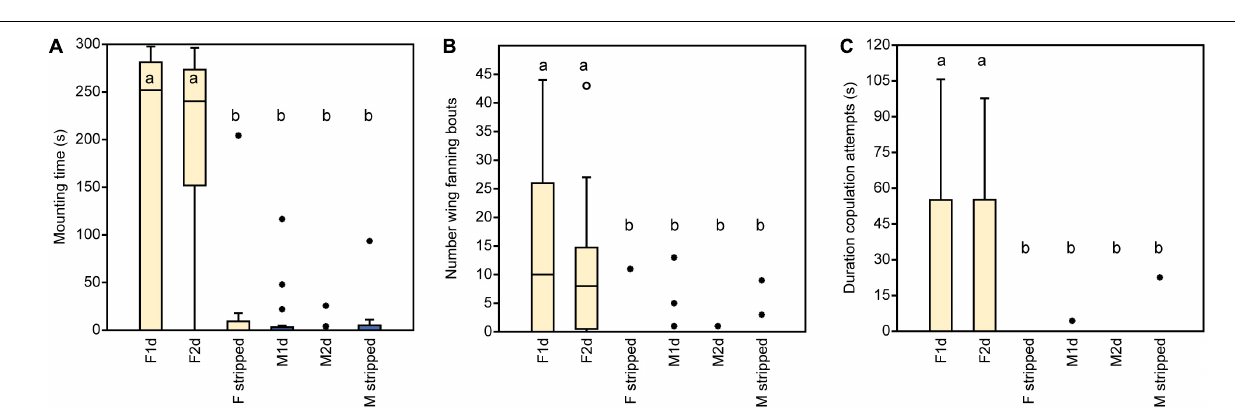
FIGURE 2 | Behavioral responses of U. rufipes males to freeze-killed 1- and 2-day-old females (F1d and F2d) and males (M1d and M2d) as well as to female and male wasps that were stripped of CHCs by solvent extraction. Panels show (A) the time males spent mounted on the dummy, (B) the number of wing-fanning bouts, and (C) the duration of copulation attempts. Box-and-whisker plots show median (horizontal line), 25–75% quartiles (box), maximum/minimum range (whiskers) and outliers ( • > 3 × box height). Different lowercase letters indicate significant differences between treatments for each parameter at p < 0.05 (Kruskal-Wallis H -test followed by multiple Mann-Whitney U -tests with sequential Bonferroni-correction, n = 20). Statistical results are given in detail in Supplementary Table S1